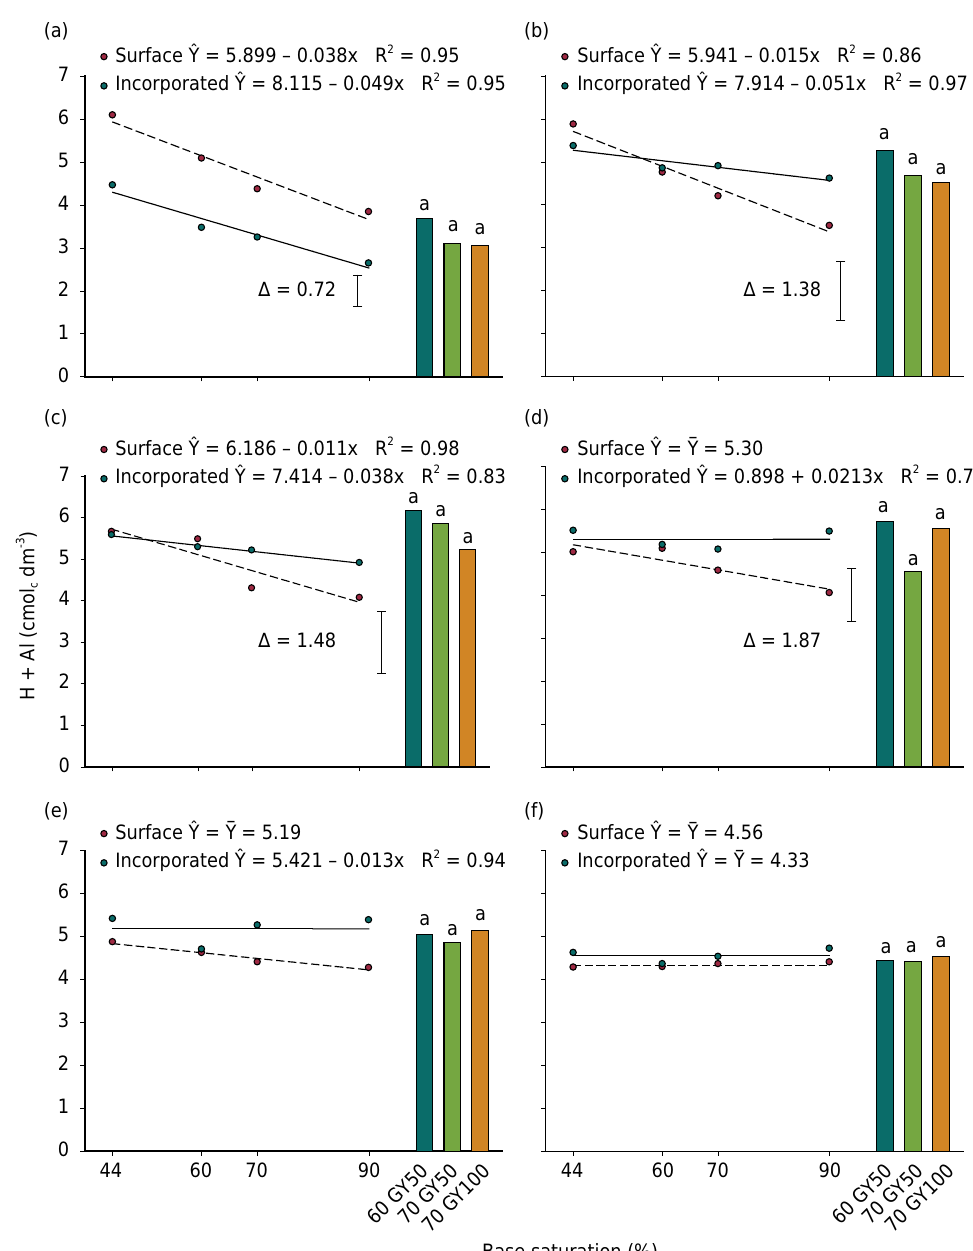
Figure 3. Potential acidity (H+Al) after reapplication of lime and phosphogypsum at different layers (m): 0.00-0.05 (a), 0.05-0.10 (b), 0.10-0.20 (c), 0.20-0.30 (d), 0.30-0.40 (e), and 0.40-0.60 (f). Different letters above the bars indicate a significant difference between the treatments with phosphogypsum based on Tukey’s test (p<0.05). The vertical bar indicates the DMS between each factorial vs additional treatment based on a Dunnett test (p<0.05). An F test revealed a significant difference between the modes of lime application to the layers presented in figures 1a (p<0.00), 1b (p<0.00), 1c (p<0.04), 1d (p<0.09), and 1e